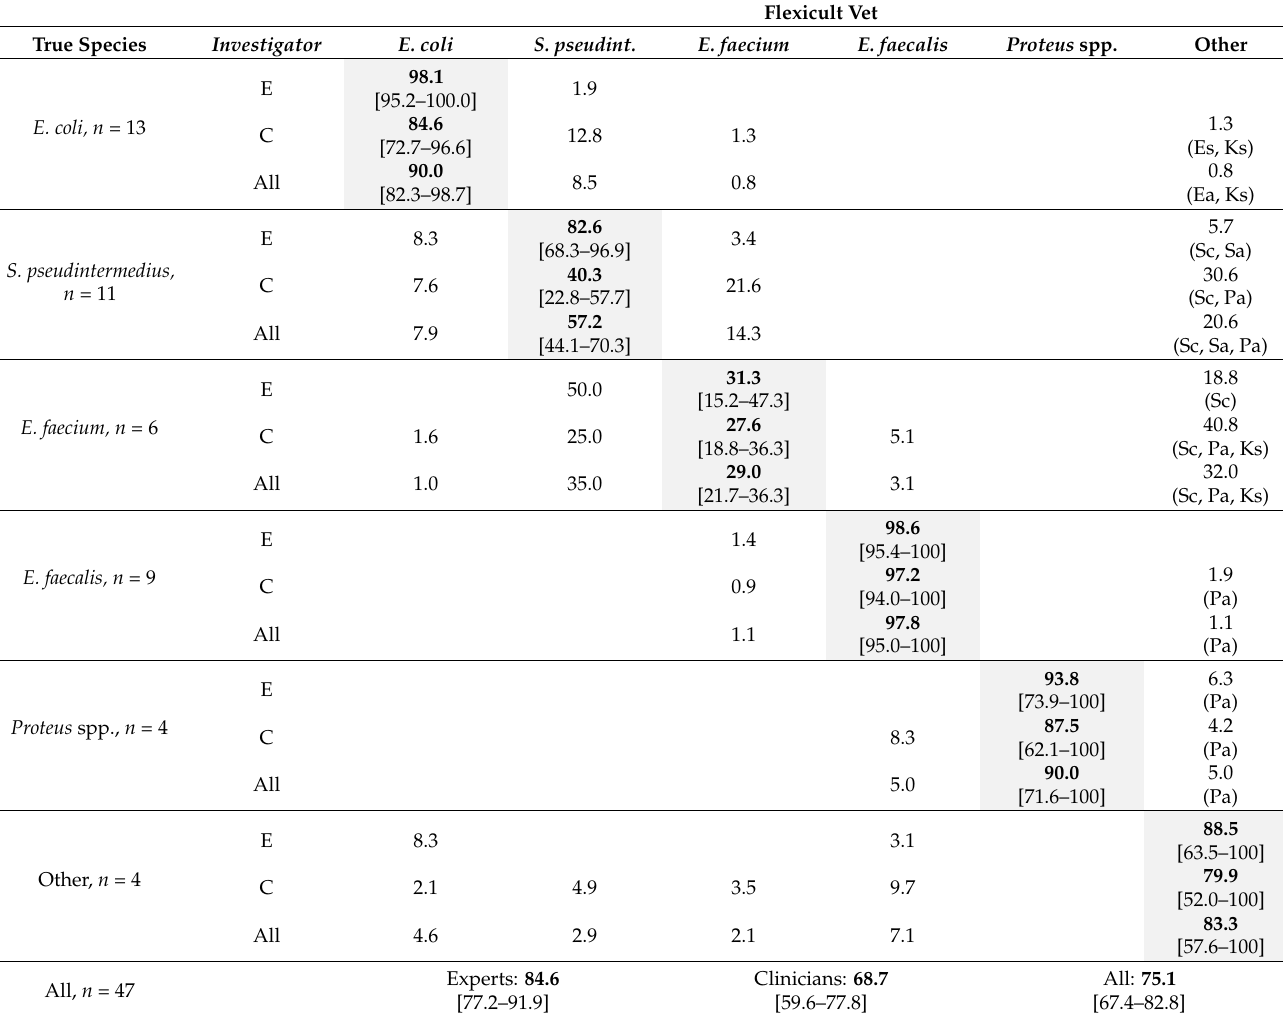
Table 1. Mean and 95% confidence intervals (CI, squared brackets) of identification accuracy (%) retrieved by experts (E) and clinicians (C). The most frequent misidentified bacteria are listed in the rounded brackets. Bacteria are abbreviated as Enterobacter spp. (Es), Klebsiella spp. (Ks), S. canis (Sc), S. aureus (Sa), and P. aeruginosa